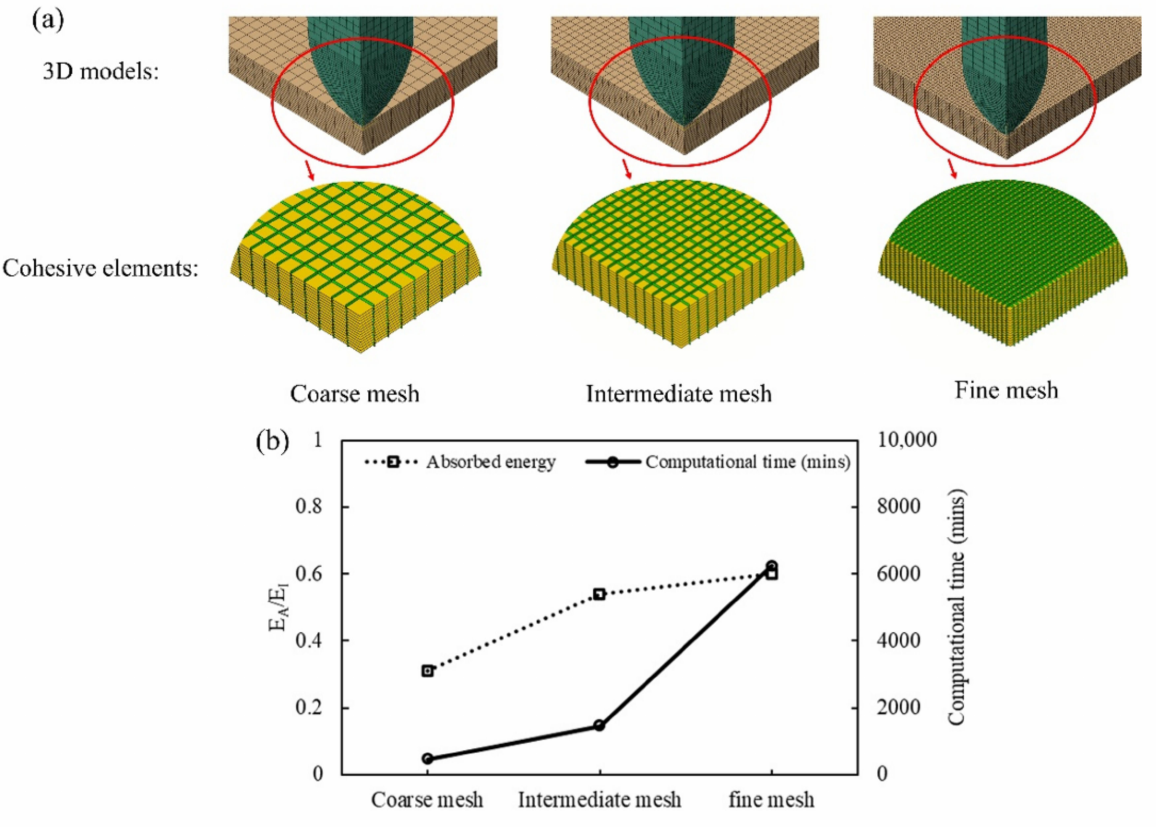
Figure 10. ( a ) Models considered for the mesh sensitivity study of low-velocity impact, ( b ) comparison of energy absorption and computational time for each mesh